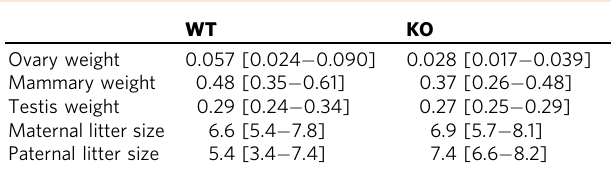
Mean values + / − 1.96 standard errors of the mean. All weights are the sum of bilateral measurements per animal in grams. Litter size measurements are strati fi ed by maternal and paternal genotype and do not include individuals that failed to conceive (i.e. they only include non-zero litter